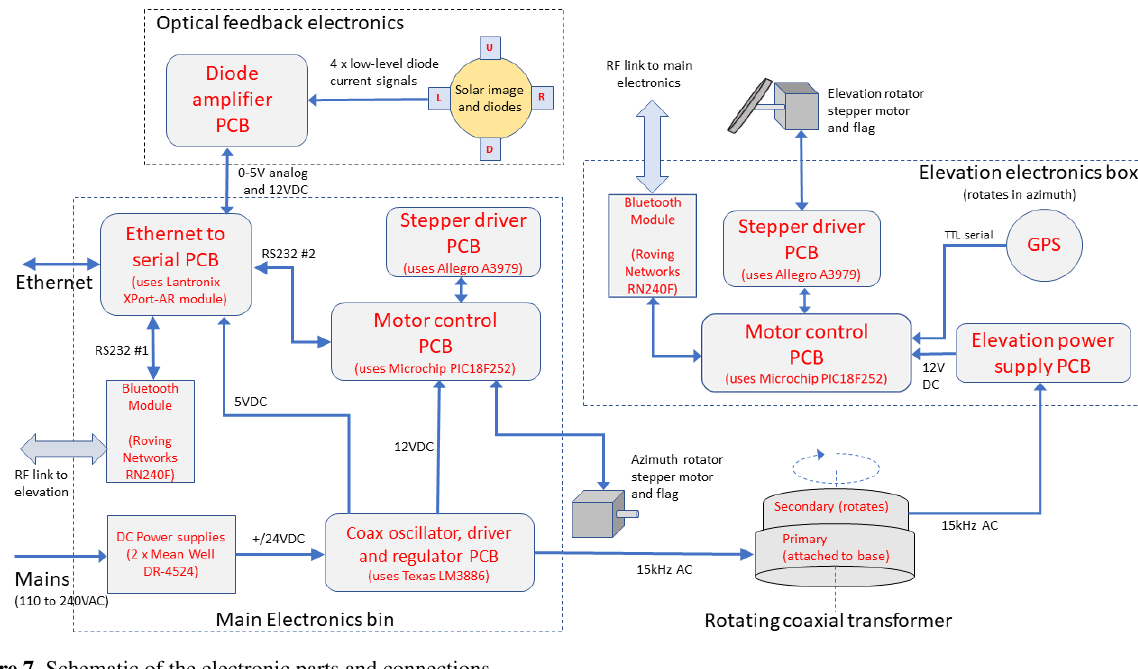
Figure 7. Schematic of the electronic parts and connections.